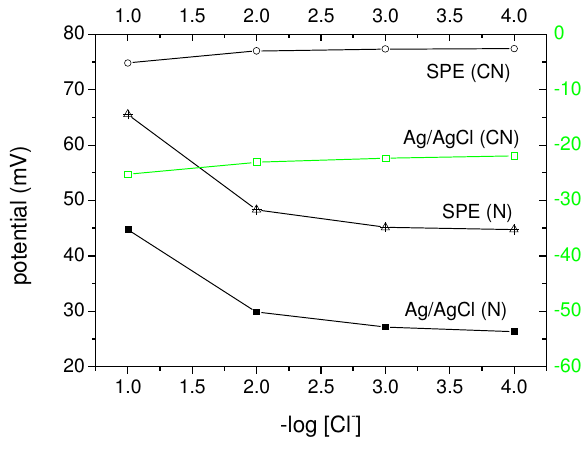
Figure 6. Cross-sensitivity of the miniaturised reference electrodes with KCl-containing membrane and protective coating towards chloride ions.